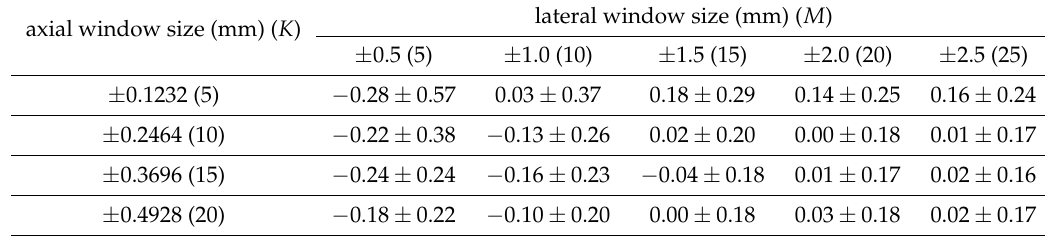
Table 2. Bias errors e bias and standard deviations σ of lateral and axial displacements at nine red points in Figure 4a estimated by the conventional 2D motion estimator with frame averaging. Beamformed echo signals were obtained with rectangular apodization. Actual lateral and axial velocities were 2 mm/s and –1 mm/s,